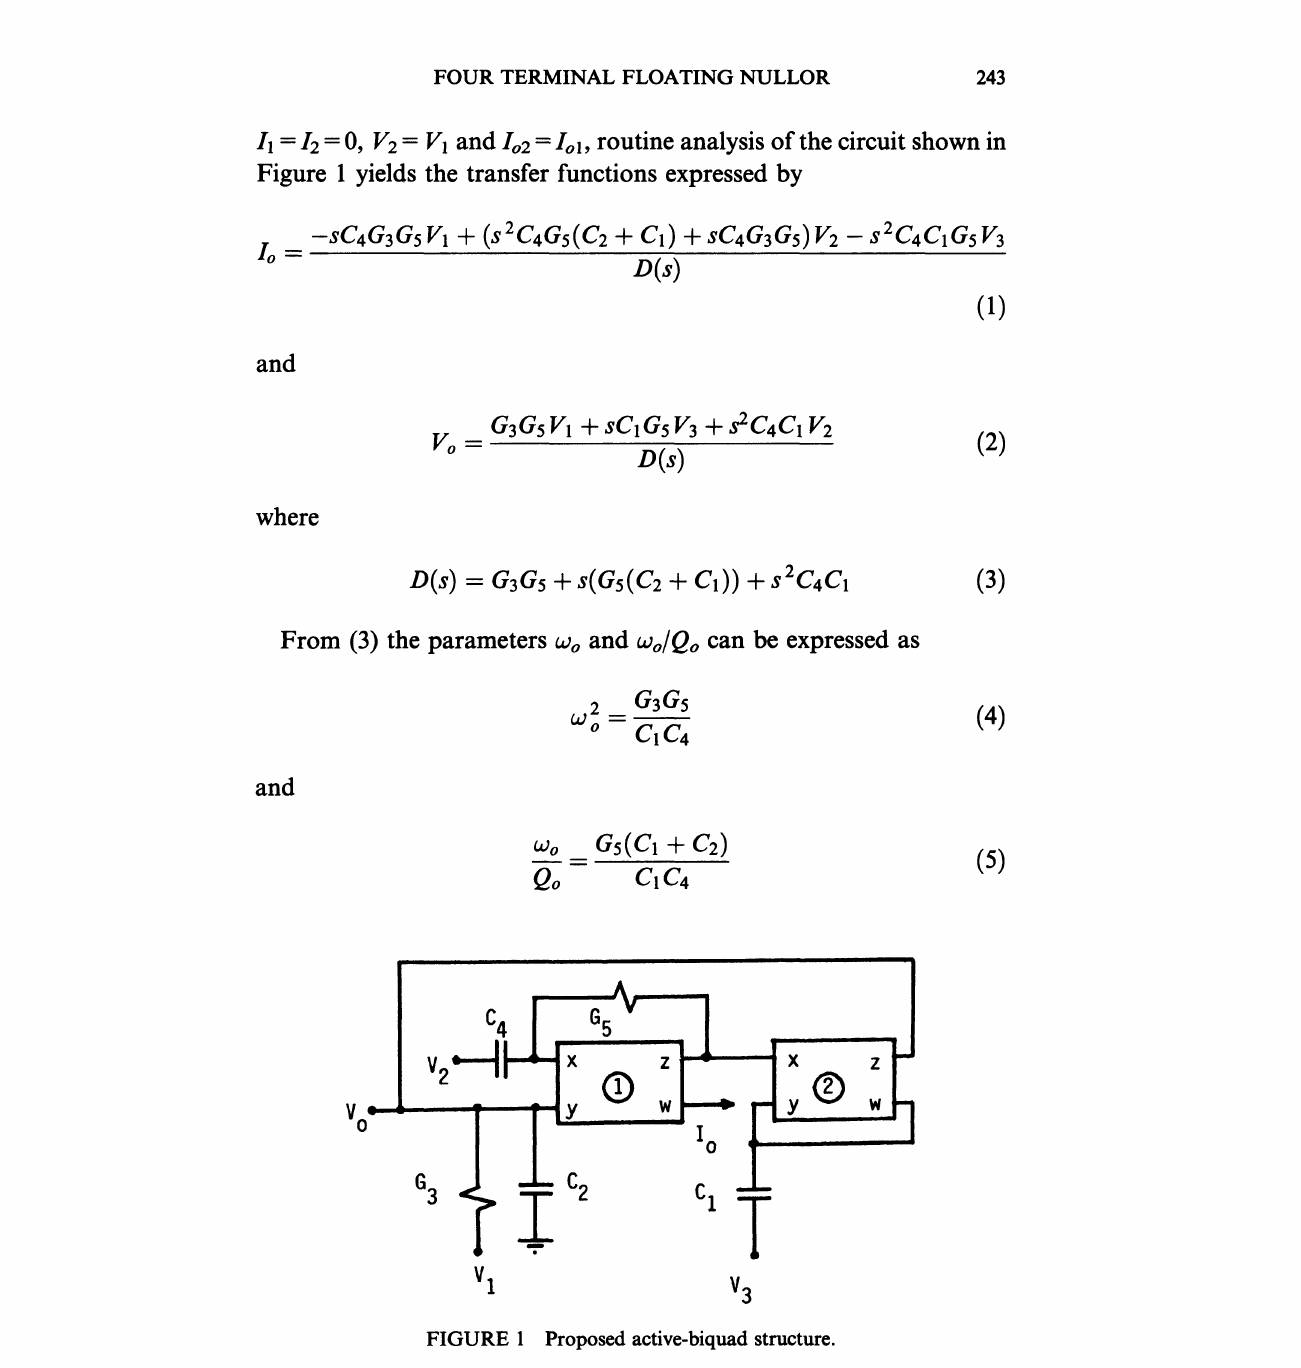
FIGURE Proposed active-biquad